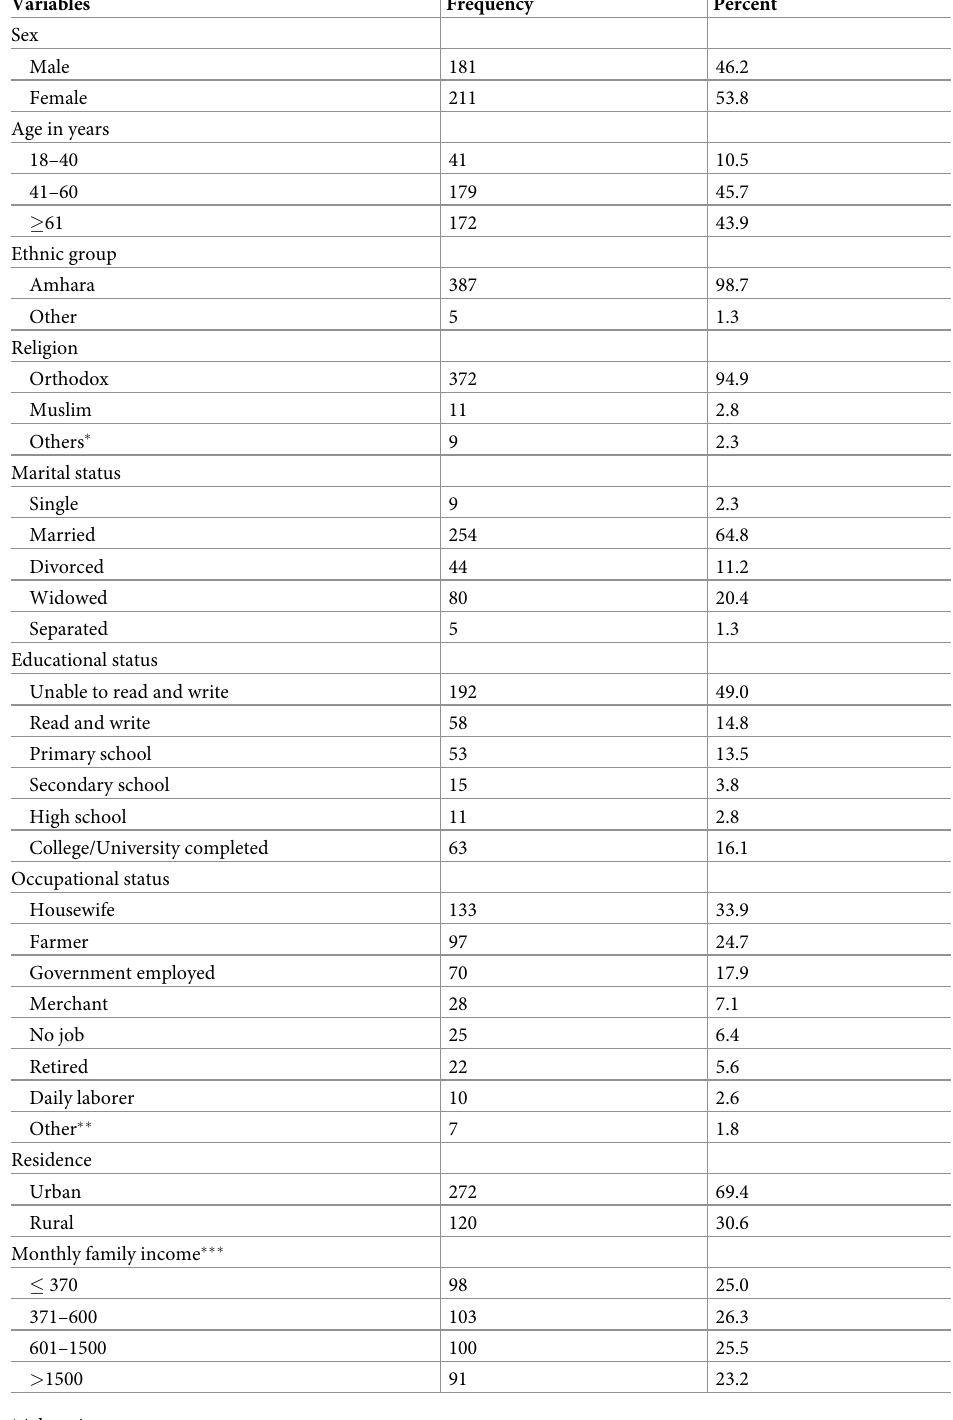
Table 1. Sociodemographic characteristics of participants (n =